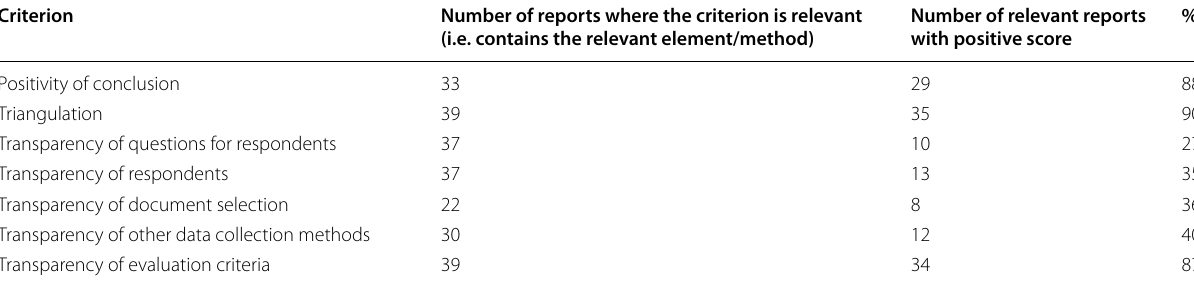
Table 2 Scores for individual criteria on which 39 evaluation reports were assessed